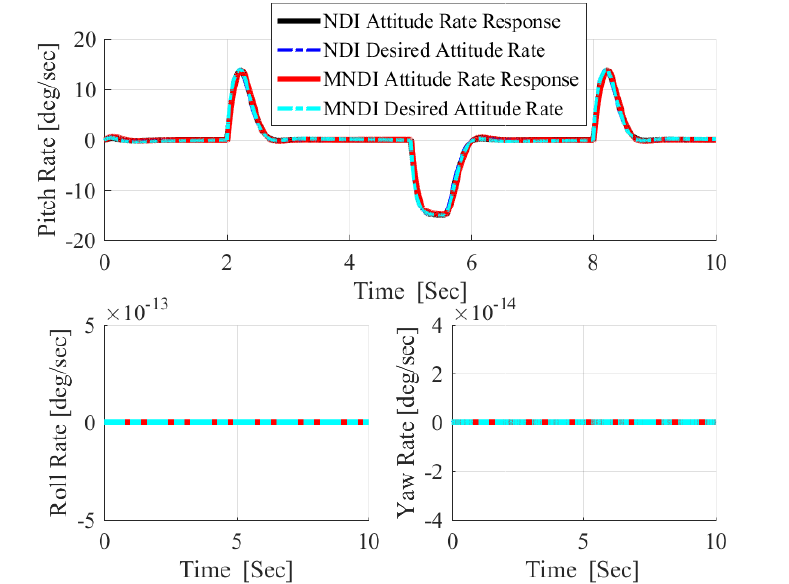
Figure 7. Inner loop rate response for outer pitch angle